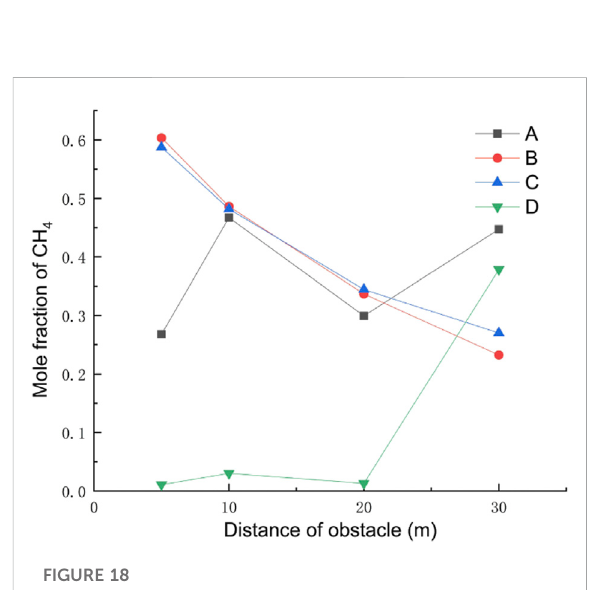
FIGURE 18 Concentration mapofmonitoringpointsatdifferentobstacle distances after 120 s.